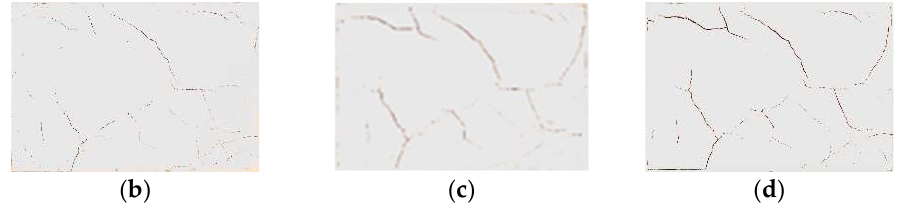
Figure 4. Cracking of specimens with a size of 30 cm × 20 cm × 2 cm. ( a ) initial stage; ( b ) crack development stage; ( c ) crack development stage; ( d ) final crack morphology.